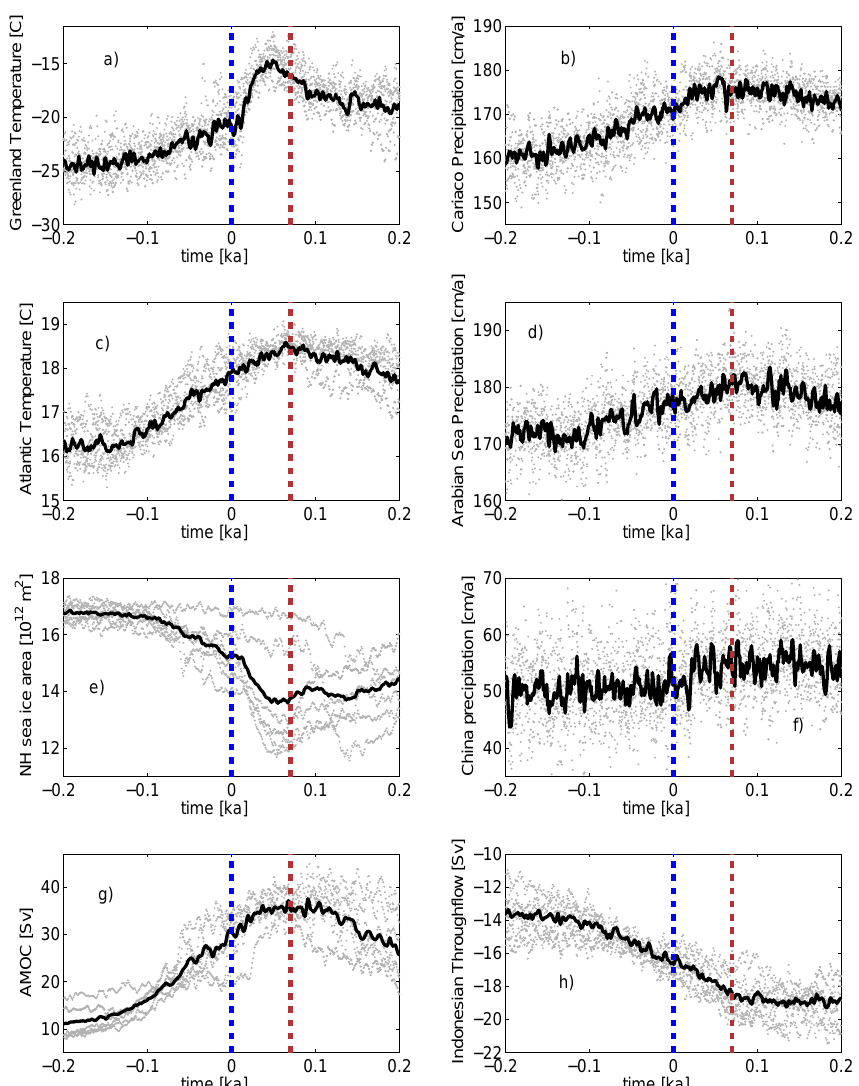
Fig. 7. Composite (thick black line) of DO stadial–interstadial transitions showing different simulated variables relative to the maximum time derivative in simulated Greenland temperatures occurring at 47.25, 43.9, 41.8, 38.3, 35.3, 33.6 and 32.34kaBP: (a) Greenland air temperature, (b) Cariaco Basin precipitation, (c) North Atlantic temperature, (d) Arabian Sea precipitation, (e) northern hemispheric sea-ice area, (f) eastern China precipitation, (g) Maximum of meridional streamfunction in North Atlantic, (h) strength of Indonesian Throughflow. The blue and red dashed lines respectively represent the time of the largest positive time derivative of Greenland temperatures and the time when North Atlantic temperatures attain the maximum value. The gray dots represent the individual data points before calculating the